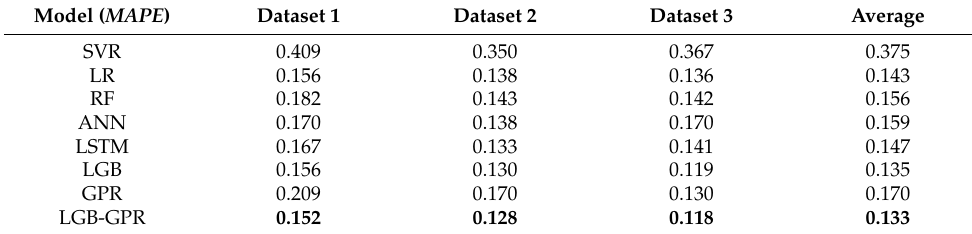
Table 4. MAPE score results statistics table.